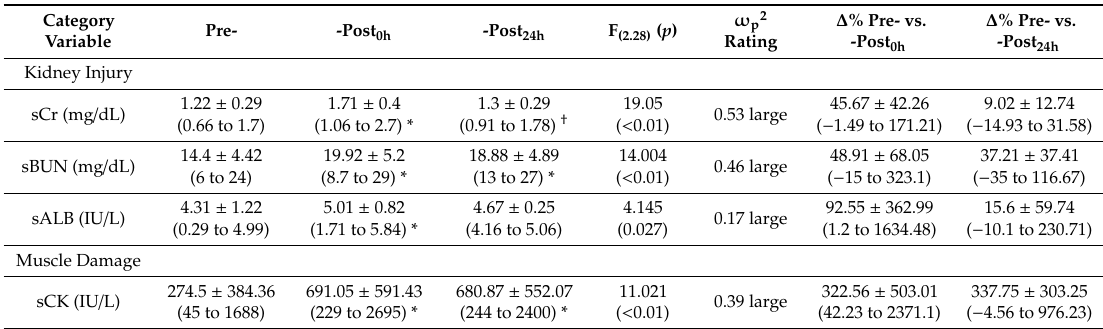
sCr: serum creatinine, sBUN: serum ureic blood nitrogen, sALB serum albumin and sCK: serum creatine kinase. * Significant di ff erences with Pre- ( p < 0.01); † Significant di ff erences with -Post 0h ( p < 0.01). Lower and upper limits were reported in